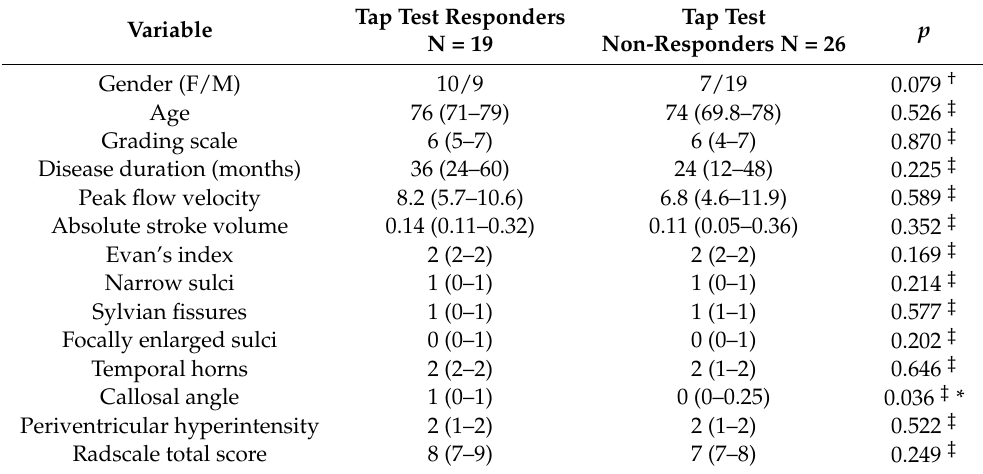
Table 2. Demographic and radiological characteristics of tap test responders and non-responders.